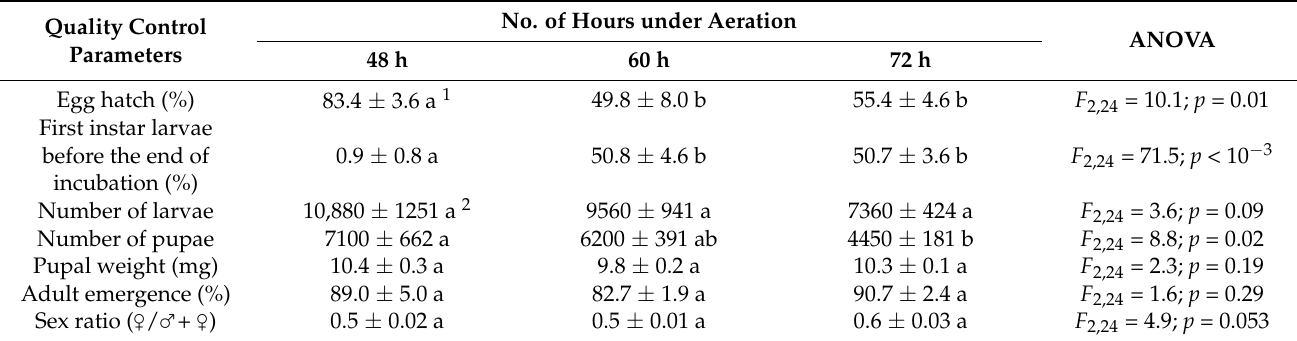
Table 1. Quality control parameters (mean ± SE) obtained after the incubation of Anastrepha fraterculus eggs at three different time periods in a bubbling thermal bath system at 25 ◦